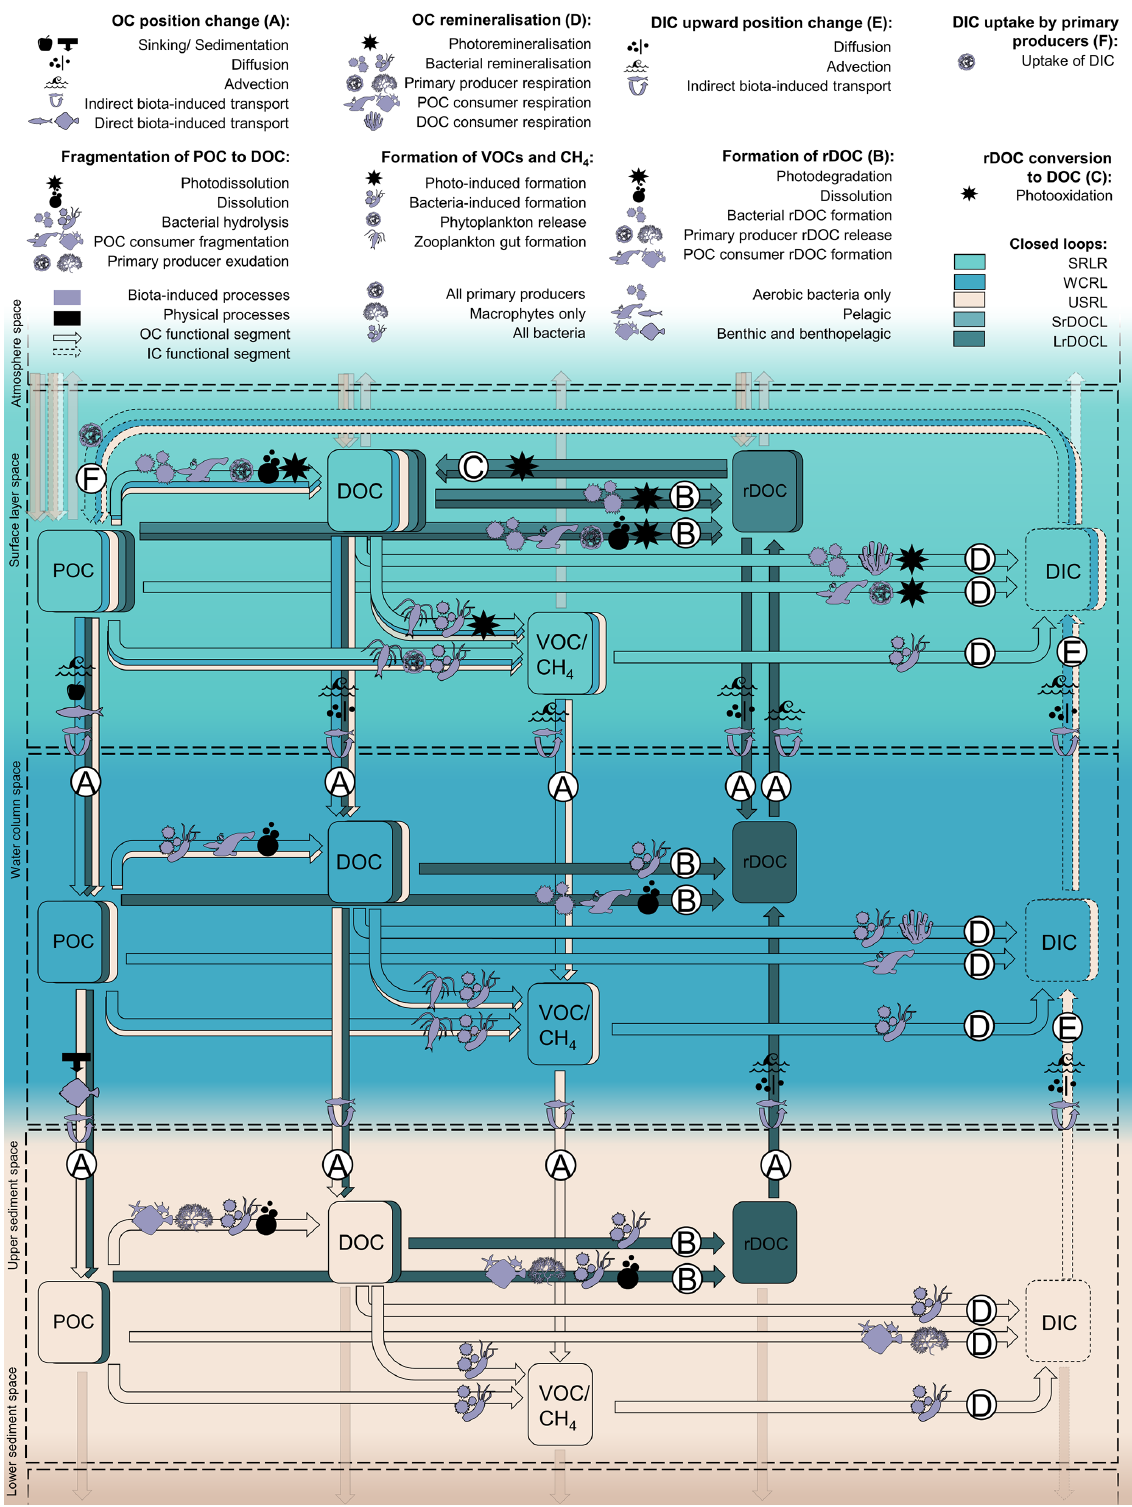
Figure 2. Defined OC structures with functional segments A–F, spaces and embedded processes, OC pools, and involved organisms. Open loops are indicated by transparent colours. Organisms can be agents (producing DOC by sloppy feeding) and part of the carbon pool (con- sumers as part of POC respiring DIC) at the same time. Fragmentation processes and pathways for DOC and VOCs/CH 4 are included. As they are not resolved in the loops, these pathways are not marked with capital